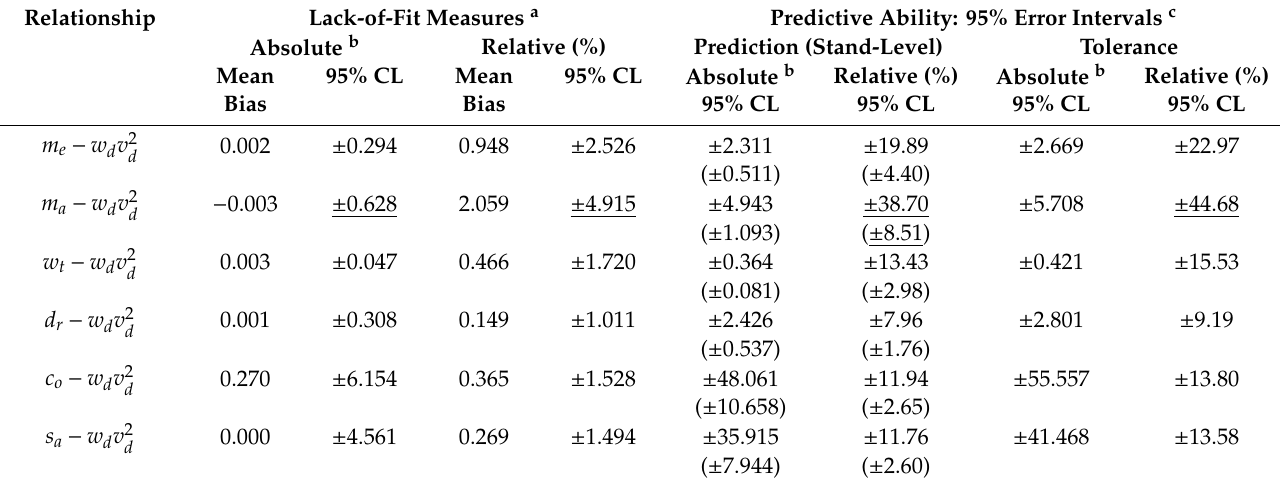
Table 7. Predictive performance measures for relationships utilizing an acoustic-based wood density